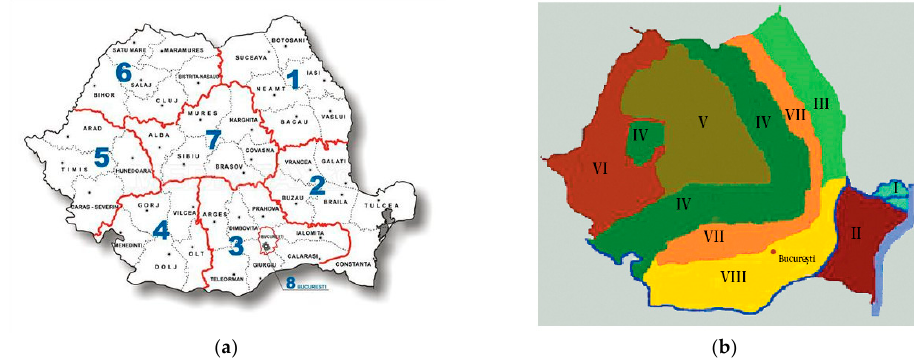
Figure 1. Territorial distribution of developmental regions of Romania and the renewable energy potential: ( a ) Development regions of Romania [47]. 1-North-East region, 2-South-East region, 3-South-Muntenia region, 4-South-West region, 5-West region, 6-North-West region, 7-Central region, 8-Bucharest-Ilfov region; ( b ) Romanian renewable energy potential [49]. I-solar energy, II-solar, biomass, and wind energy, III-micro-hydro, wind, and biomass energy, IV-biomass, micro-hydro, and wind energy, V-micro-hydro and biomass energy, VI-geothermal and wind energy, VII-biomass and micro-hydro energy, VIII-biomass, geothermal, and solar